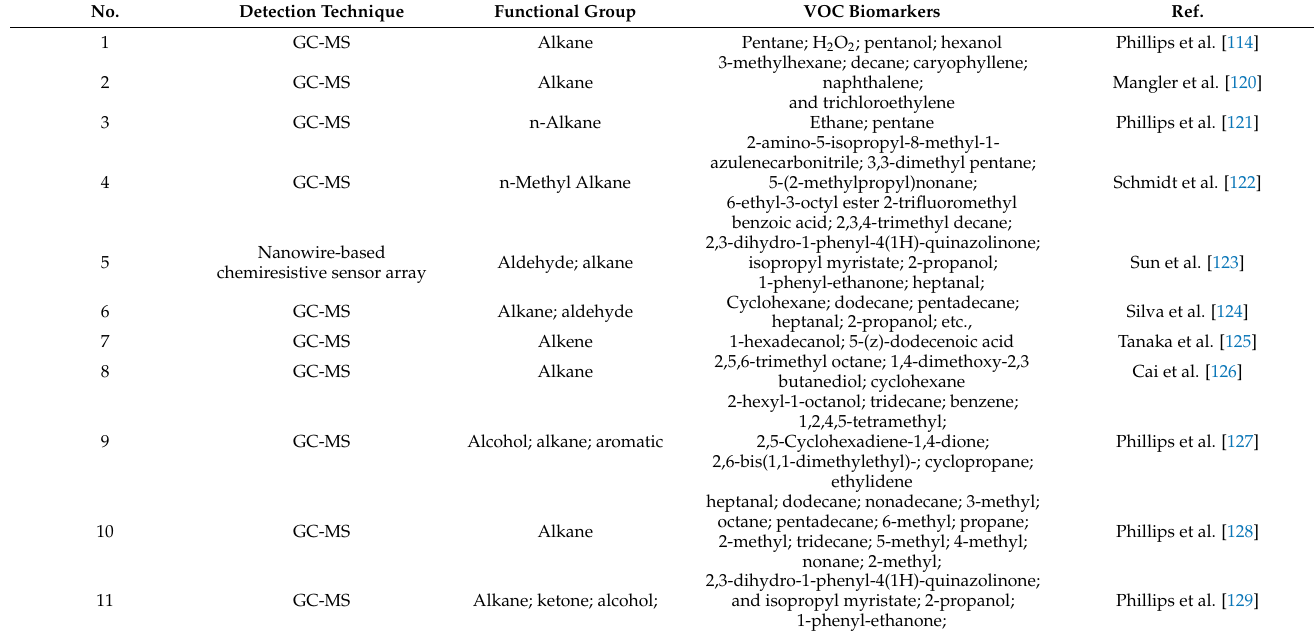
Table 5. Various biomarkers and their relevant functional group specific towards breast